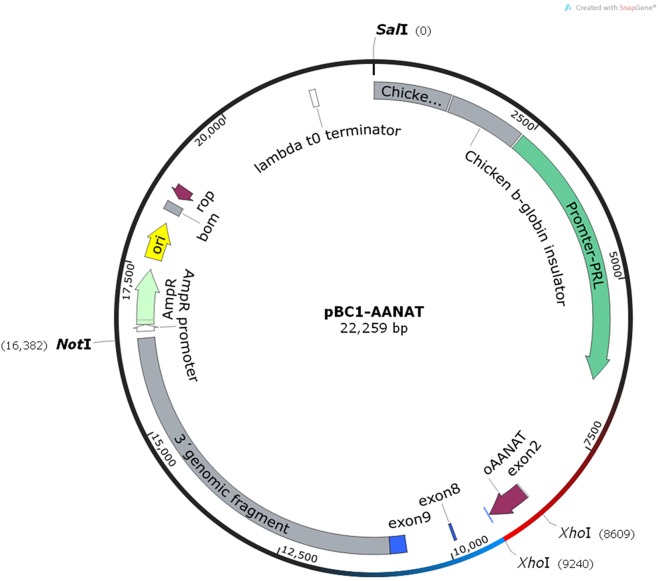
The structure of pBC1-AANAT plasmid.